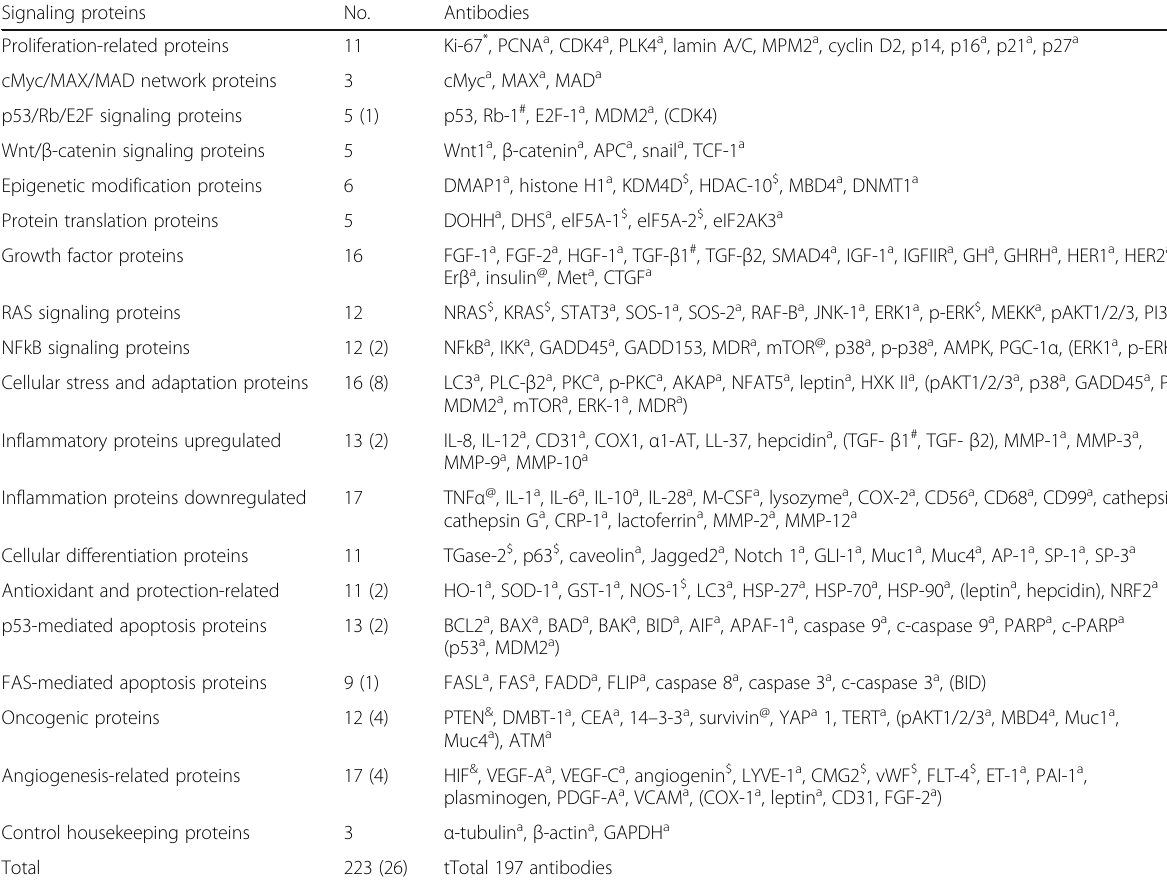
Table 2 Antibodies used in the study Signaling